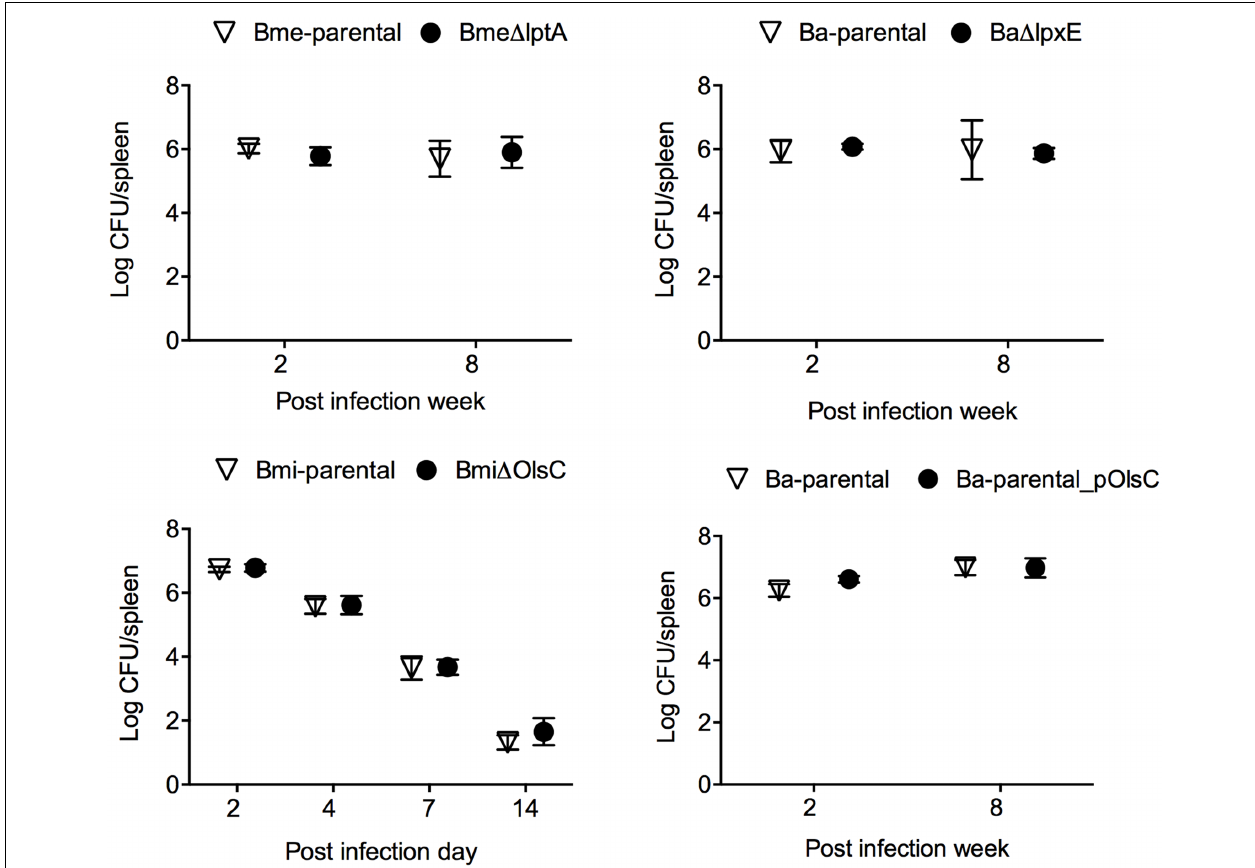
FIGURE 6 | The OM properties that depend on LptA, LpxE, and OlsC are not required for Brucella virulence in the mouse model. BALB/c mice were inoculated intraperitoneally with 5 × 10 4 (Bme-parental, Bme (cid:49) lptA, Ba-parental, and Ba (cid:49) lpxE) or 1 × 10 4 (Bmi-parental and Bmi (cid:49) olsC) CFU/mouse and CFU/spleen determined at the indicated times. Each point represents the mean ± standard error of the logarithm of CFU in the spleens of five